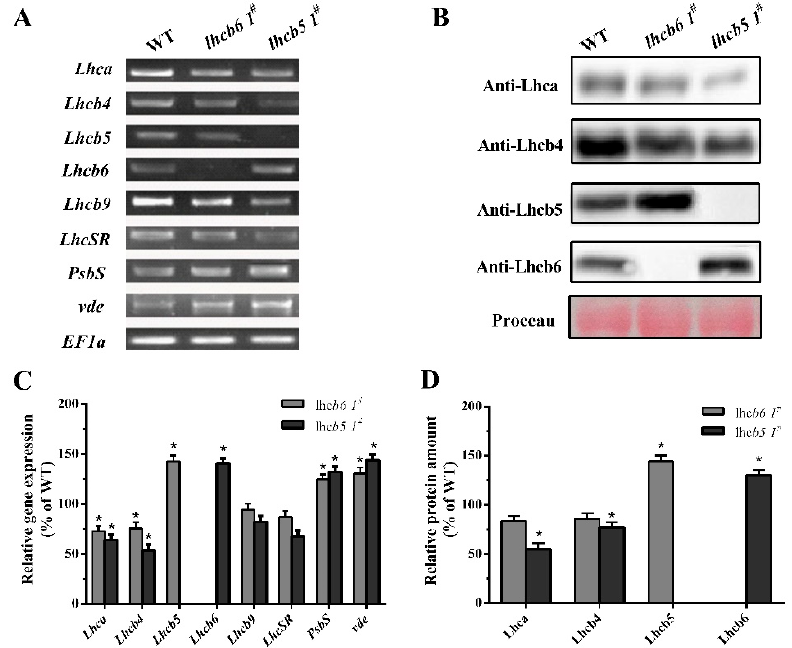
Figure 2. Analysis of Lhc genes or protein accumulation in wild-type and mutants. ( A ) The expression of Lhc -related genes was analyzed by RT-PCR. EF1a was used as reference gene. Lhc , Light-harvesting complexes. PsbS , PSII subunit S. vde , violaxanthin de-epoxidase. ( B ) Immunoblotting of the Lhca, Lhcb4, Lhcb5 and Lhcb6 in wild-type and mutants. Rubisco proteins were used as loading controls